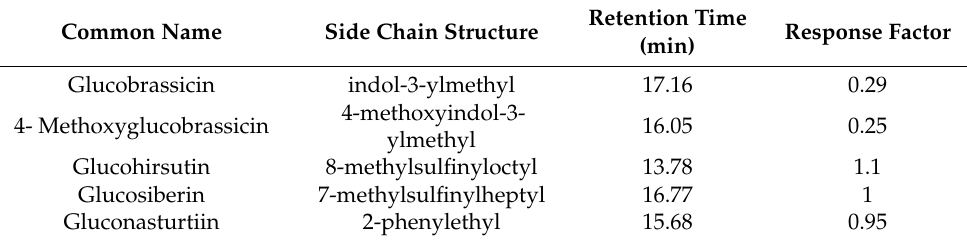
Table 1. Relative response factor values of the desulfoglucosinolates from watercress shoot extracts and their retention times on C18 column [28].